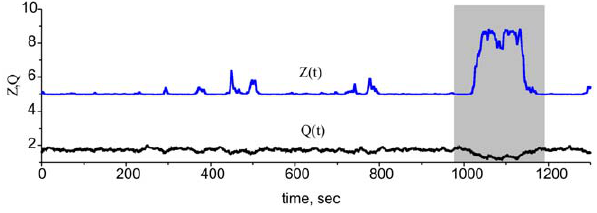
Figure 8. Simulation of ECM-proteases feedback regulating excitability in terms of the original model (1)–(6), (9), (10). Due to the integration of the Poisson input train, Q fluctuates near the Q ‘ value (see Eq. (7) in Methods). In the bistable mode, this fluctuation leads to spontaneous switches between high and low ECM concentra- tions and thus high and low activity values (time interval shown in gray). Parameter values: z 0 = p 0 = 0, z 1 = p 1 = 1, h z = 1,k z = 0.15, h p =1.5,k p =0.05, k q =0.01, c p =0.1, I 0 =4.5, b 0 =6, c Z =0.0345, c ZR =0.0, a q = 0.0001 msec 2 1 , b q = 0.01 msec 2 1 , a z = 0.001 msec 2 1 , b z = 0.01 msec 2 1 , a p = 0.001 msec 2 1 , b p = 0.01 msec 2 1 and f in- put =0.2 kHz .